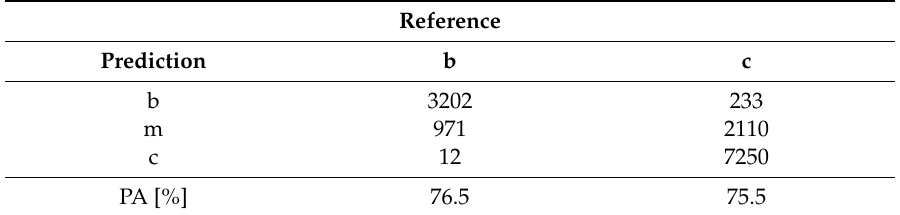
Table 4. Confusion matrix and accuracies for the whole area generated by validation based on the forest management plans. b = broadleaf, m = mixed forest, c =